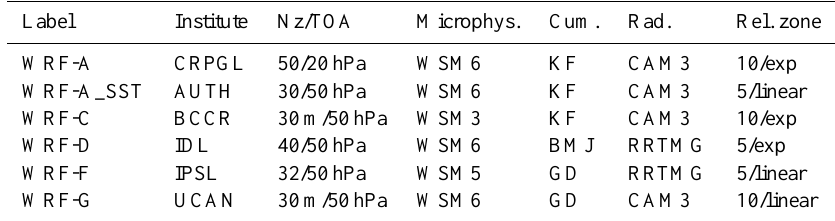
Table 1. WRF configurations participating in the study. Label Institute Nz/TOA Microphys. Cum. Rad. Rel. zone WRF-A CRPGL 50/20hPa WSM6 KF CAM3 10/exp WRF-A_SST AUTH 30/50hPa WSM6 KF CAM3 5/linear WRF-C BCCR 30m/50hPa WSM3 KF CAM3 10/exp WRF-D IDL 40/50hPa WSM6 BMJ RRTMG 5/exp WRF-F IPSL 32/50hPa WSM5 GD RRTMG 5/linear WRF-G UCAN 30m/50hPa WSM6 GD CAM3